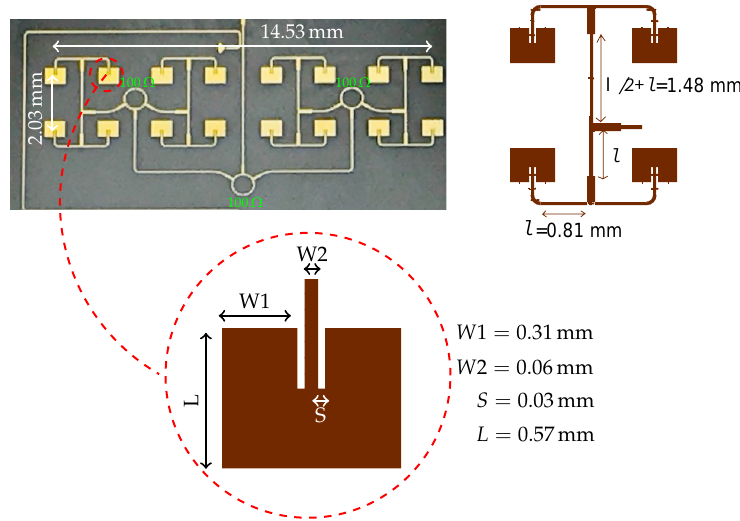
Figure 11. Picture of the fabricated 8 × 2 antenna array and the ADS layout with dimensions of the antenna element and 2 2 antenna array.